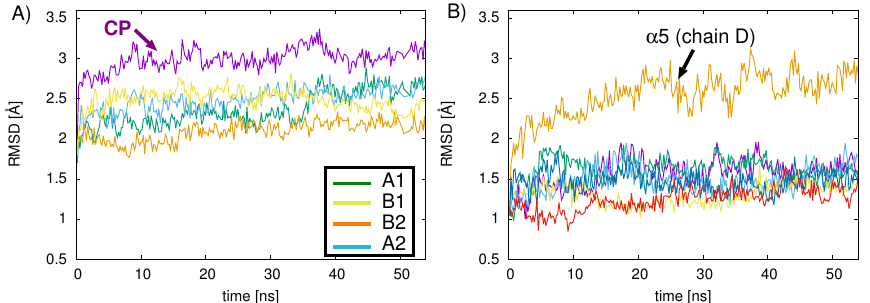
Figure 4. ( A ) protein The backbone RMSD (Å) relative to the crystal structure is shown over the 54 ns simulation time for the apo 20S CP (purple) and for the four ring systems A 1 (green), B 1 (yellow), B 2 (orange), and A 2 (blue) and ( B ) for the A 1 subunits: α 1 (chain G) red, α 2 (chain A) purple, α 3 (chain B) green, α 4 (chain C) light blue, α 5 (chain D) orange, α 6 (chain E) yellow, α 7 (chain F) dark blue. Subunit α 5 (chain D) (orange), indicated with the arrow, shows the largest RMS deviations over the simulation time period, arising from less structured loops.